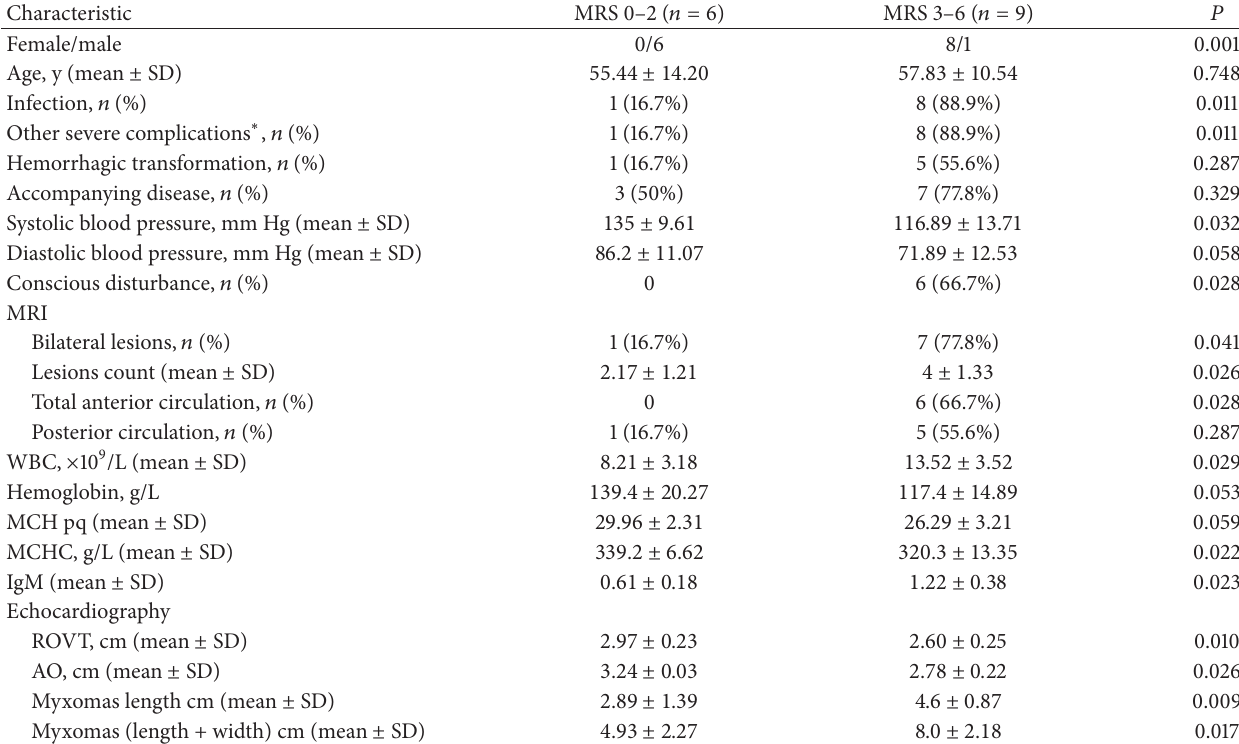
Table 2: Features of different outcomes of patients with myxoma with brain